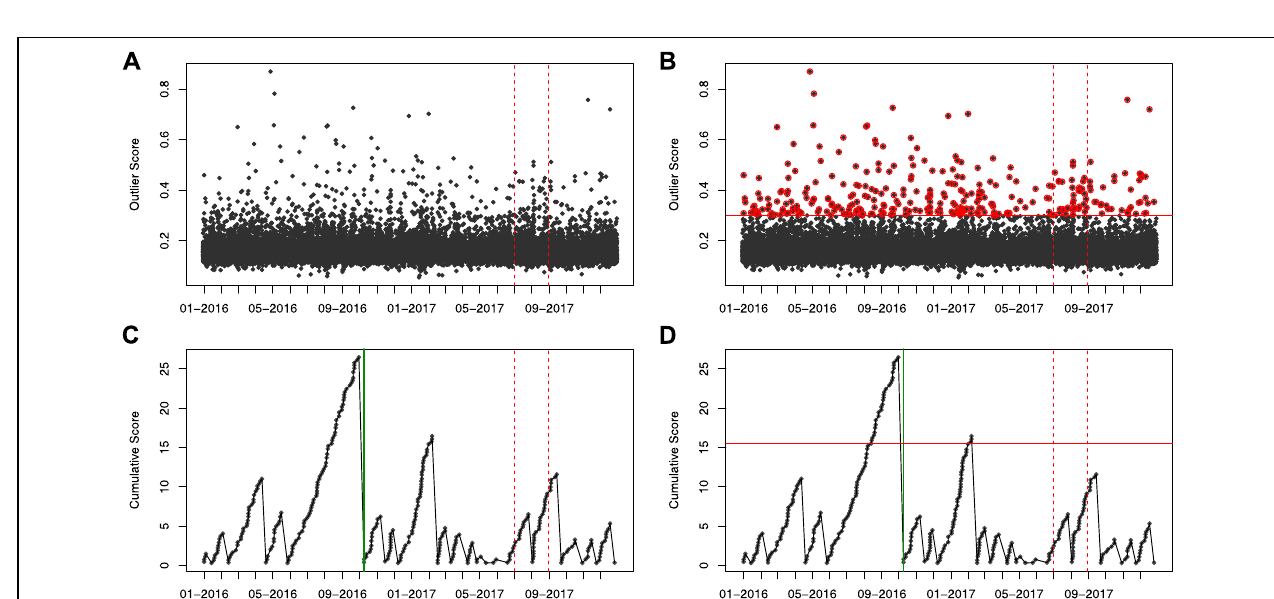
FIGURE 3 | Illustration of the actions in the proposed method. In this example, only T09 data is used. In each of the figures, there are two vertical dashed red lines. The one to the right is the time boundary between the training and test data. The one to the left is the 60-days mark before the test set. (A) plots the output of LoMST anomaly score calculation. (B) adds the offset, so that only anomaly scores above the offset are accumulated in the next step. Those scores are highlighted in red color. (C) is the plot of cumulative anomaly score, where one can see the effect of accumulation and tracking. The vertical green line indicates the time of a true gearbox failure recorded in the training data. (D) adds the control limit for detection, which is the horizonal red line. With this control limit, it flags two alarms in the training data and none in the test data. One of the two alarms is a true positive, with the early warning lead time of 89 days and the other is a false alarm.